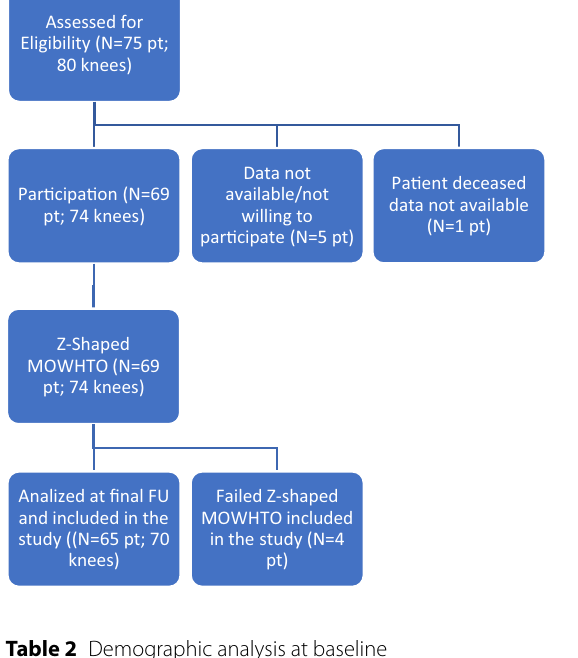
Table 2 Demographic analysis at baseline